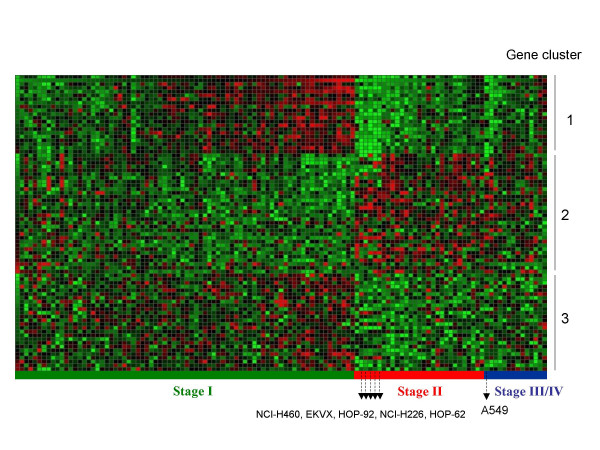
Subclassification of 6 lung adenocarcinoma cell lines into tumor stages. Gene expression of the 79 gene discriminant is illustrated by a heat map. Red and green represent high and low levels of expression respectively. The y-axis represents 79 genes and the x axis represents 113 lung adenocarcinomas and 6 NSCLC cell lines. 6 cell lines are labeled and 113 adenocarcinomas are grouped in to stage I, II and III/IV.